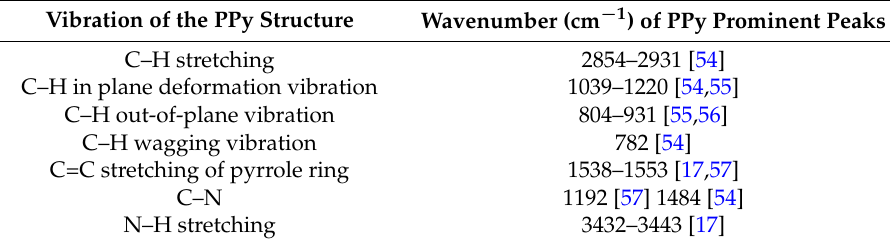
Table 1. FT-IR spectroscopic analysis of